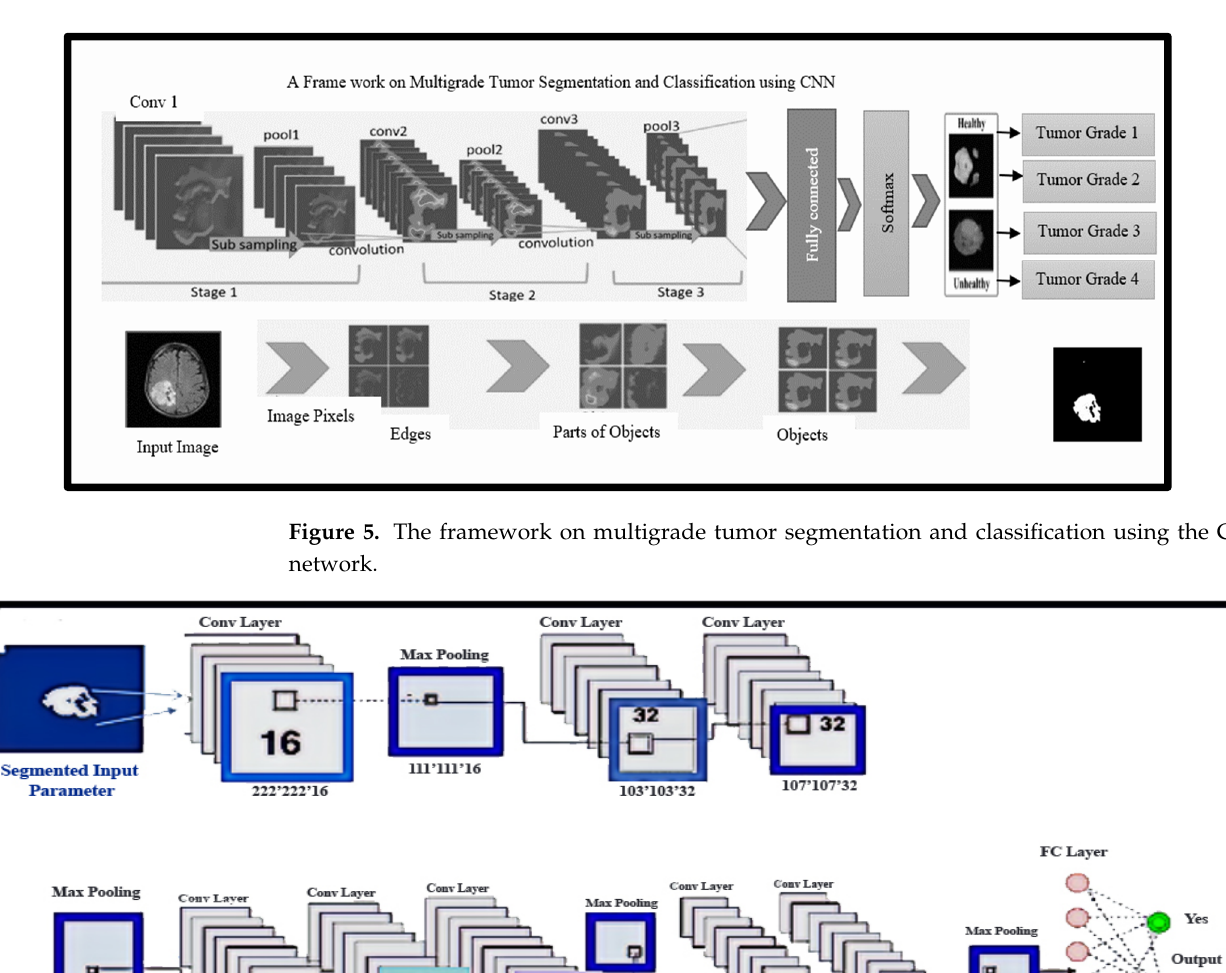
Figure 6. Diagrammatic representation on cascaded CNN architecture on brain tumor segmenta-